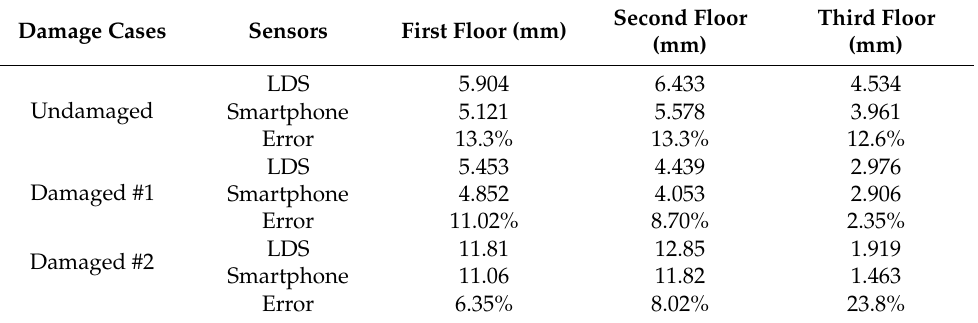
Table 2. Maximum displacements as recorded by the laser displacement sensors and smartphones. Damage